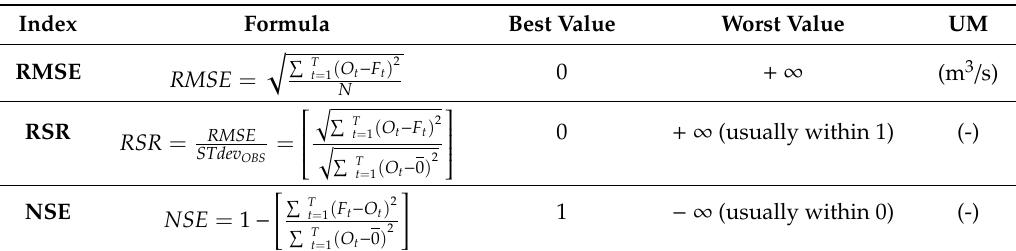
Table 3. Formula, best and worst values and unit of measure (UM) for continuous indices. Where T is the number of observed/forecasted days, F is forecasted flow, O is observed flow and N the total number of the data.